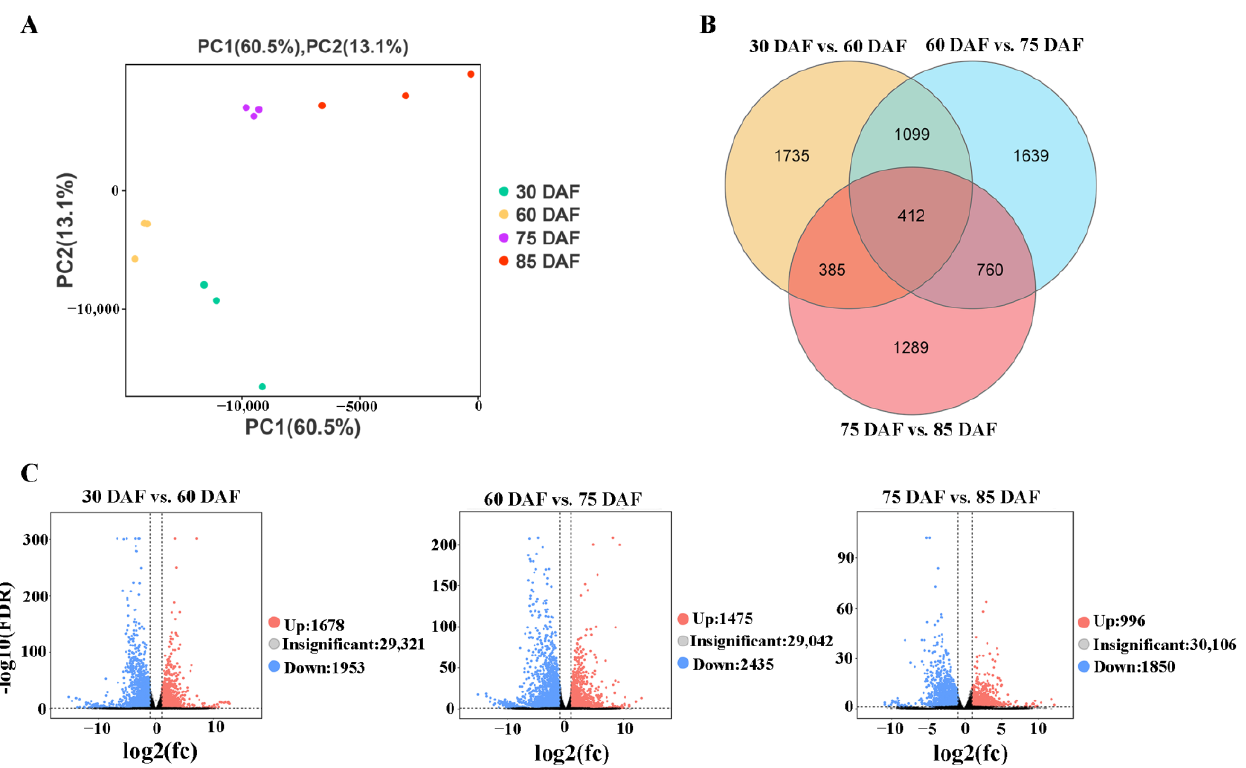
Figure 2. Profiling the DEGs in the pericarp during litchi fruit development. ( A ) 2D PCA score plot of the samples at the four development stages of 30, 60, 75, and 85 DAF, as indicated in Figure 1A. ( B ) Venn diagram of the DEGs of the 30 DAF vs. 60 DAF, 60 DAF vs. 75 DAF, and 75 DAF vs. 85 DAF comparison pairs. ( C ) Volcano plots of the DEGs of 30 DAF vs. 60 DAF, 60 DAF vs. 75 DAF, and 75 DAF vs. 85 DAF comparison pairs. Black dots represent nonDEGs, red dots represent upregulated DEGs, and green dots represent downregulated DEGs.